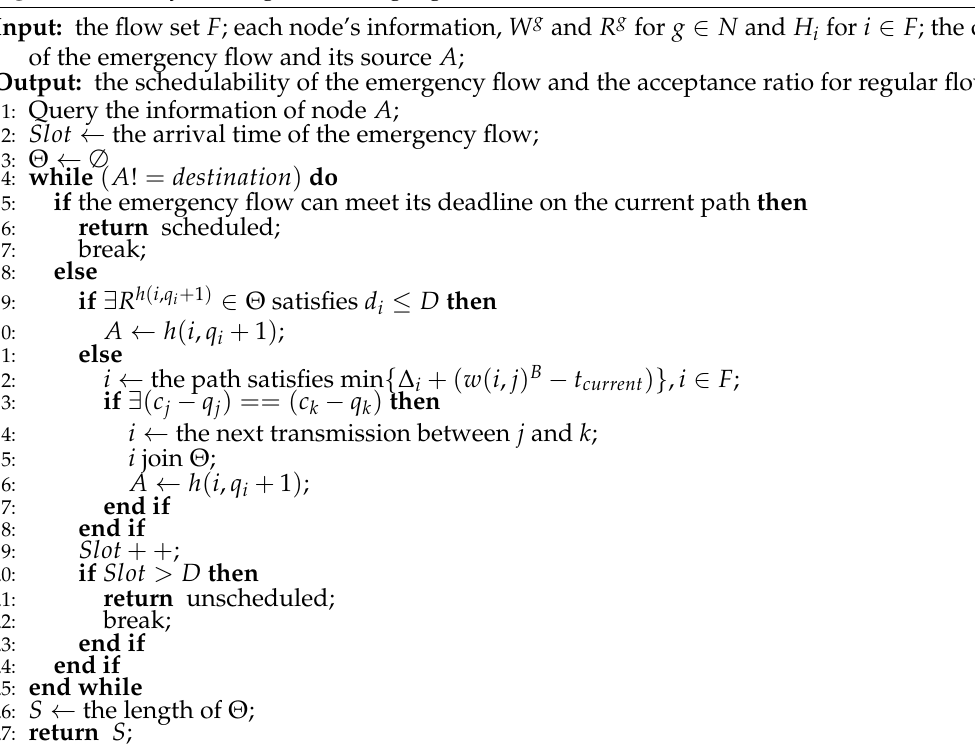
Algorithm 3 Lazy stealing scheduling